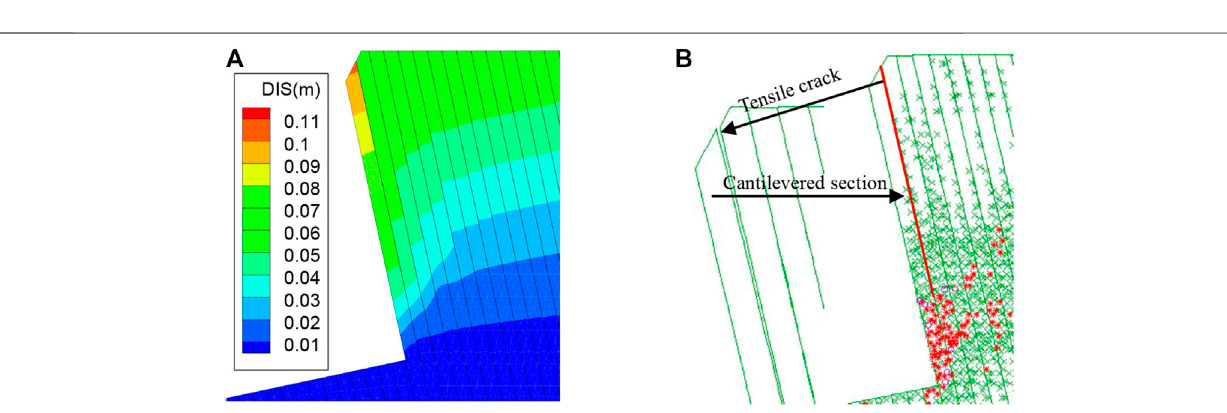
Frontiers in Earth Science |